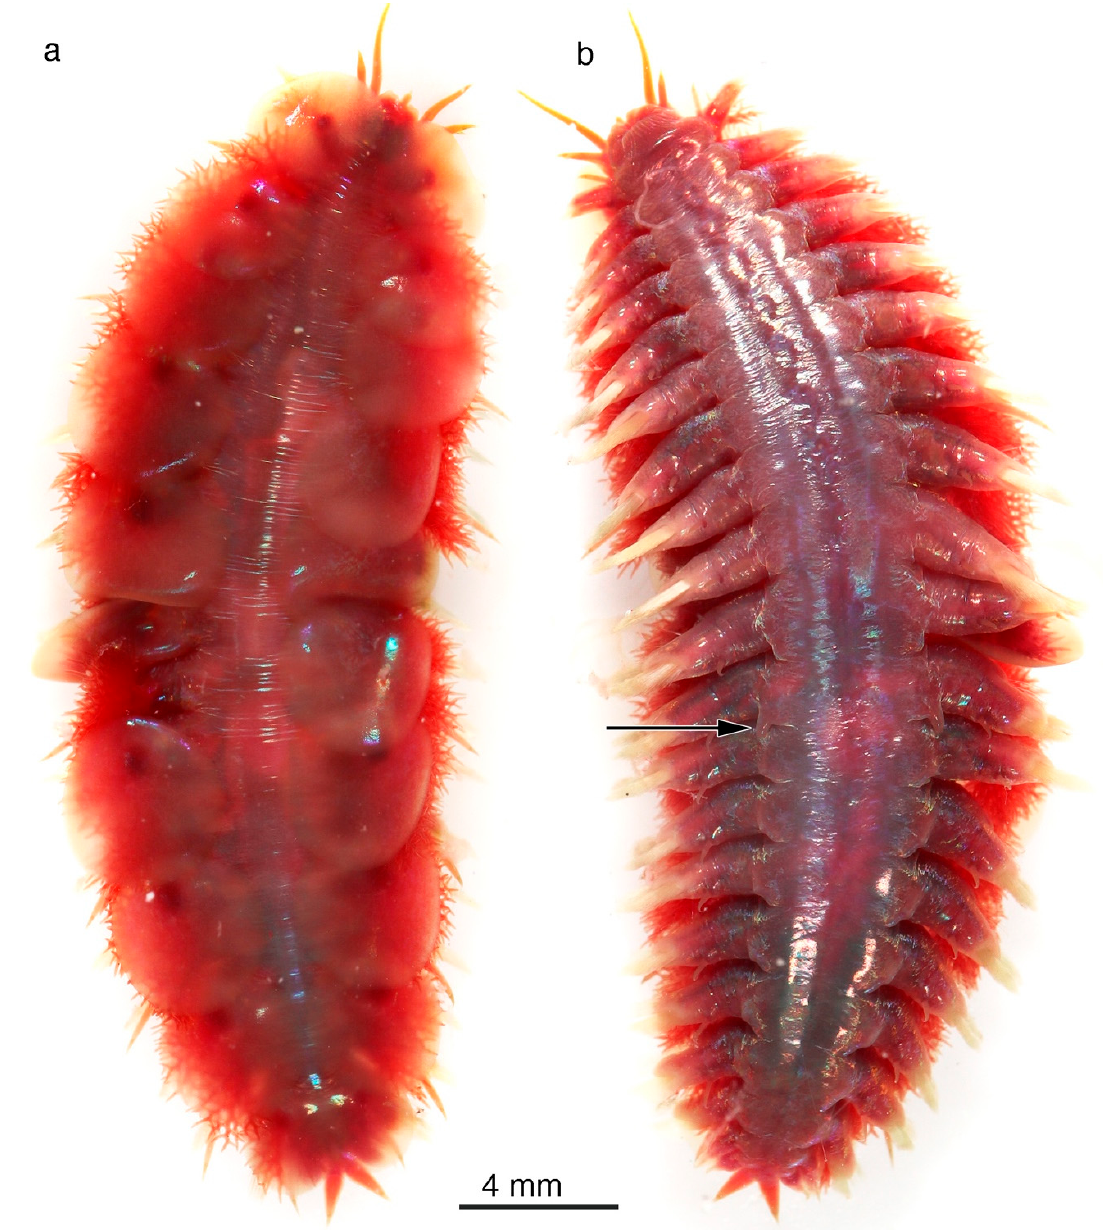
Figure 10. Branchipolynoe halliseyae n. sp. live male paratype (SIO-BIC A6690). ( a ) Dorsal view. ( b ) Ventral view. Arrow indicates elongated ventral papilla of Segment 12.